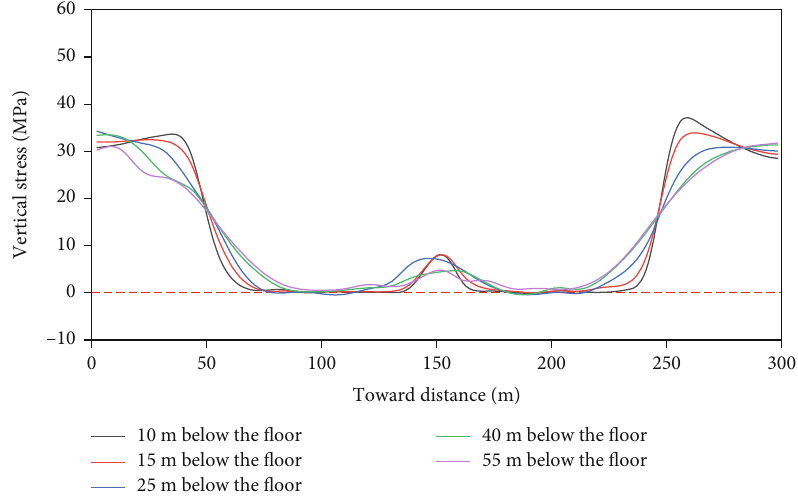
Figure 13: Distribution law of vertical stress in the underlying fl oor rock of the No. 8 coal